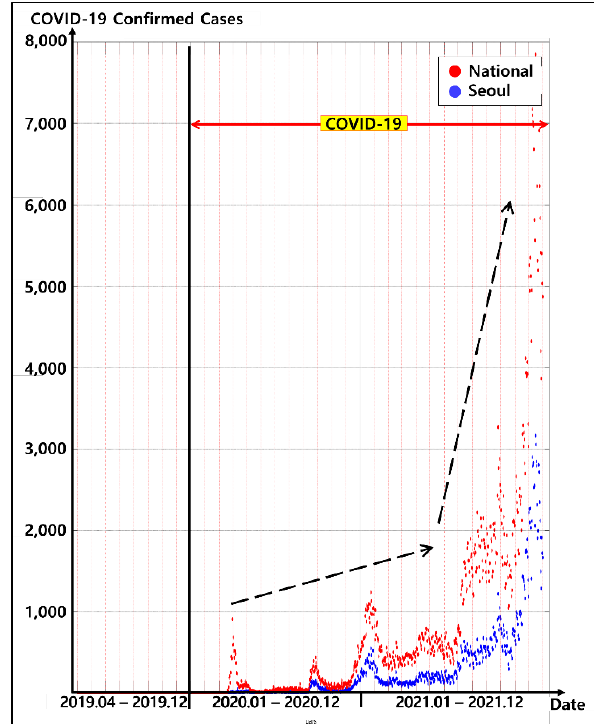
Figure 4 . Number of COVID-19 Confirmed Cases in